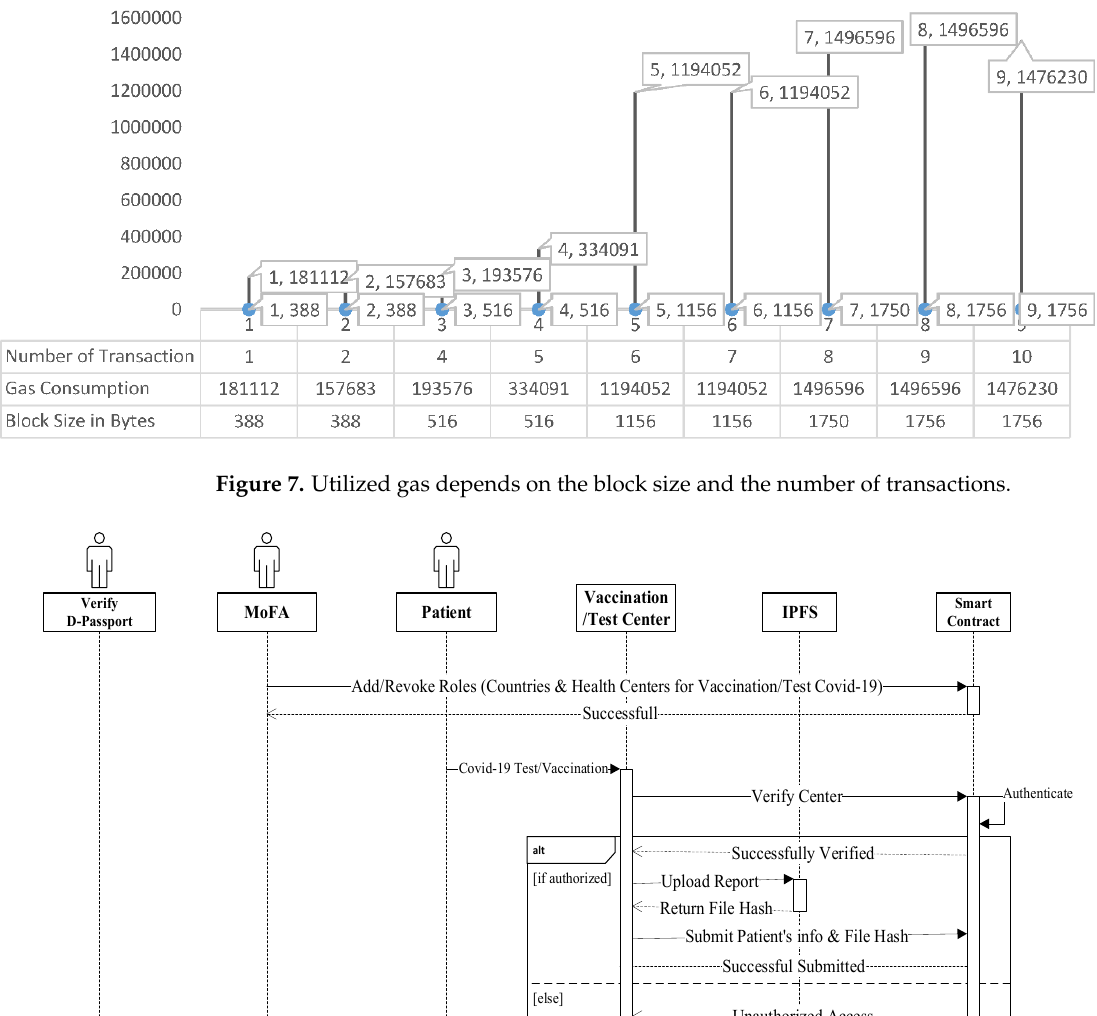
Figure 7. Utilized gas depends on the block size and the number of transactions.